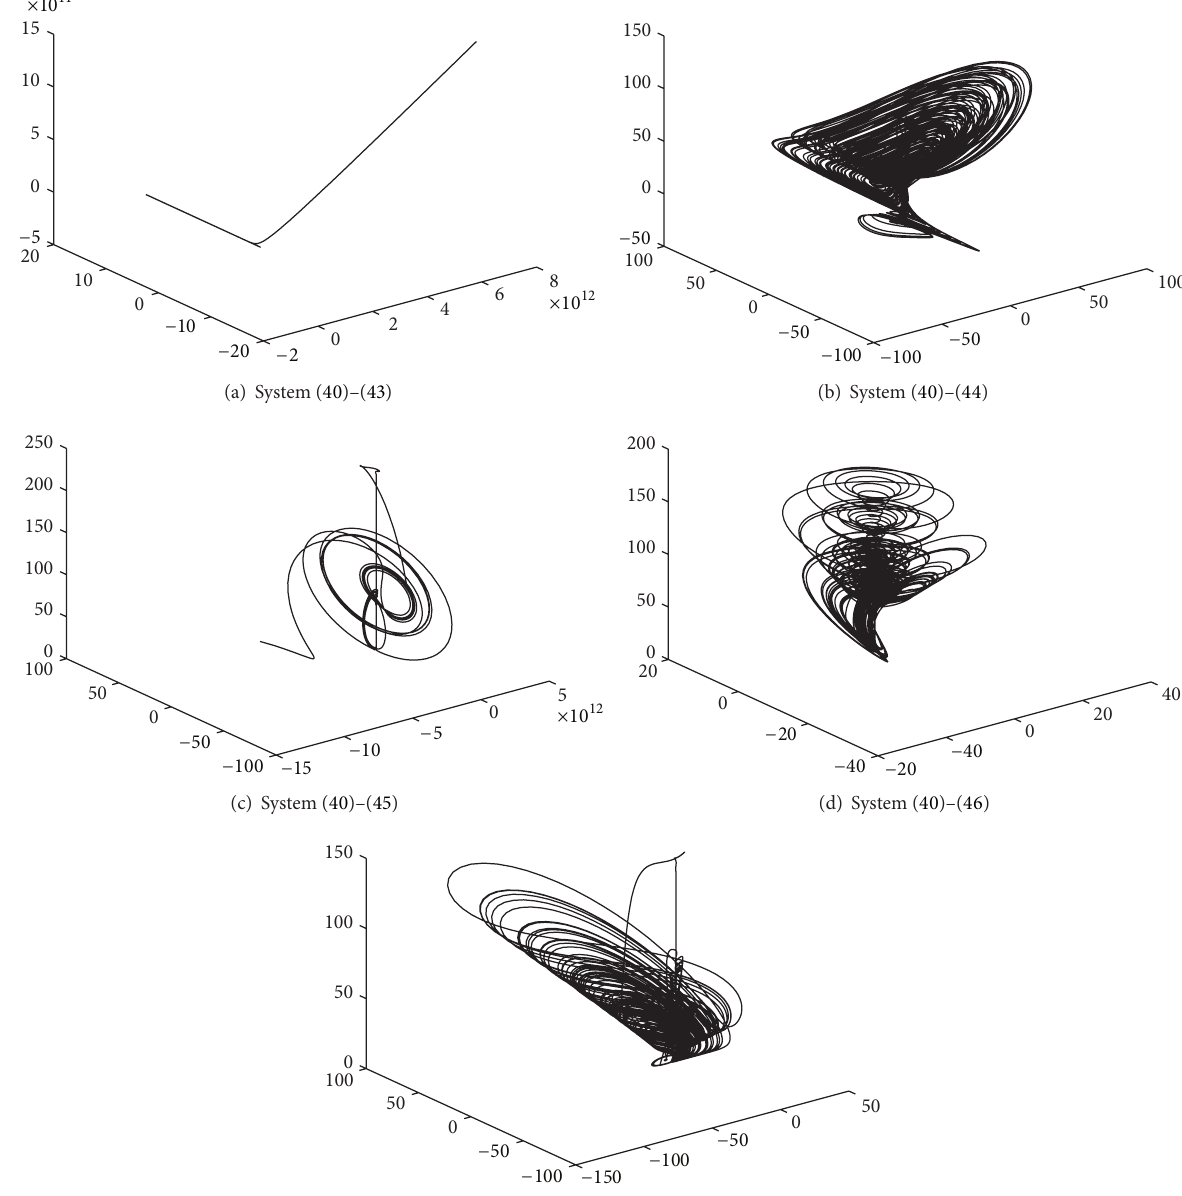
Figure 7: Switched system between system (40) and